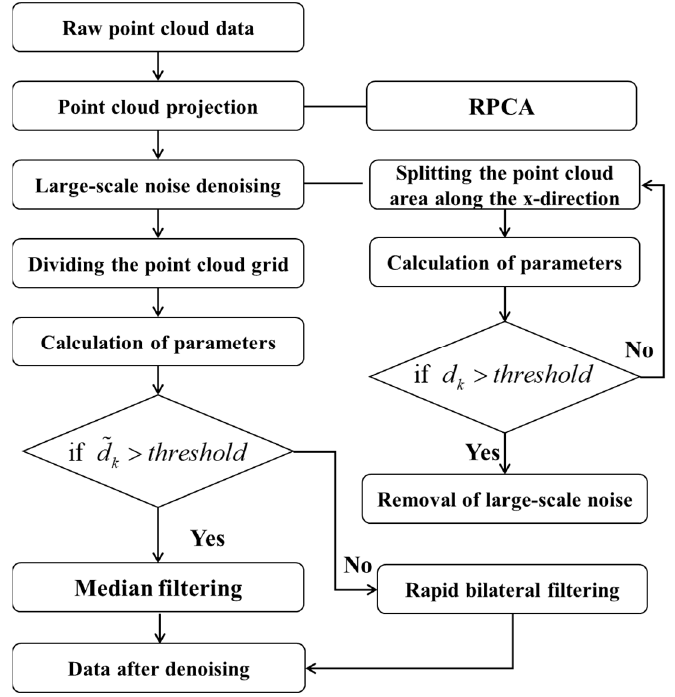
Figure 1. Denoising algorithm fl ow.